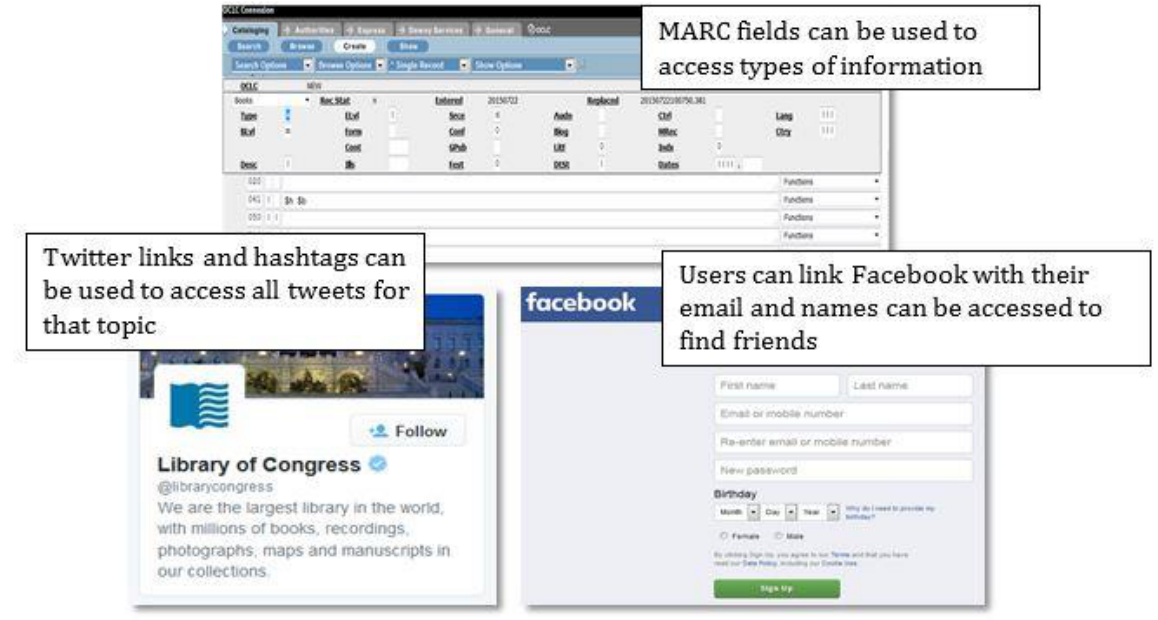
Figure 1 From Top Left to Right- OCLC MARC Record, Twitter, and Facebook